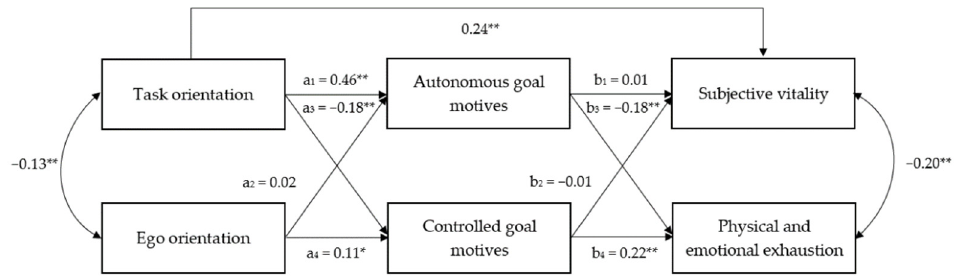
Figure 2. Path model of the associations between task and ego orientation, goal motives, subjective vitality, and physical and emotional exhaustion. * p < 0.05, ** p < 0.01.